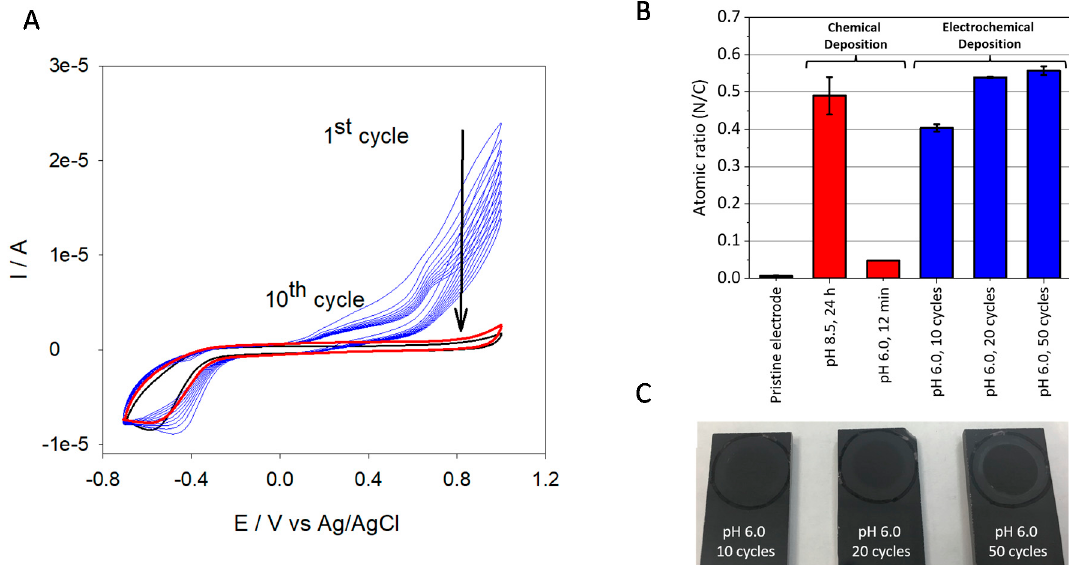
Figure 6. ( A ) A typical cyclic voltammetry experiment performed at 50 mV·s − 1 in the presence of sodium phosphate buffer on the pristine amorphous carbon electrode ( _____ ) and on the electrode covered with an AMN-based film ( _____ ) after 10 CV cycles (performed at 50 mV·s − 1 ) in the presence of AMN at 10 mg·mL − 1 ( _____ ). The black vertical arrow indicates the evolution of the faradaic current from the first to the 10th CV cycle. ( B ) Average nitrogen-to-carbon (N/C) elemental ratios acquired from XPS spectra on pristine carbon electrode before and after chemical or electrochemical deposition of AMN-based films ( n = 3 , error bars represent one standard deviation; lines are drawn to guide the eye). All depositions was carried out in the presence of 10 mg·mL − 1 AMN. Electrochemical deposition was performed with CV at a scan rate of 50 mV·s − 1 . ( C ) Appearance of AMN based films deposited with increasing number of CV sweep cycles. Reproduced with permission from [16], Copyright Elsevier, 2018.